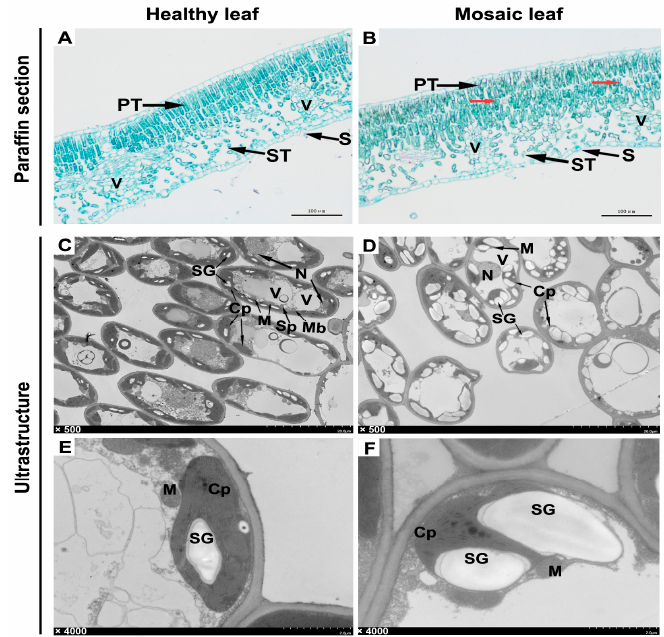
Figure 5. Observation of paraffin section and ultrastructures of leaves. ( A , B ) Paraffin section. ( C – F ) Ultrastructures. PT, palisade tissue. ST, spongy tissue. V, vascular tissue. S, stoma. Cp, Chloroplast. M, Mitochondrion. N, Nucleus. Sp, Spherosome. Mb, Microbody. SG, Starch Grain. V, Vacuole. The red arrows indicate unidentified granular matter.